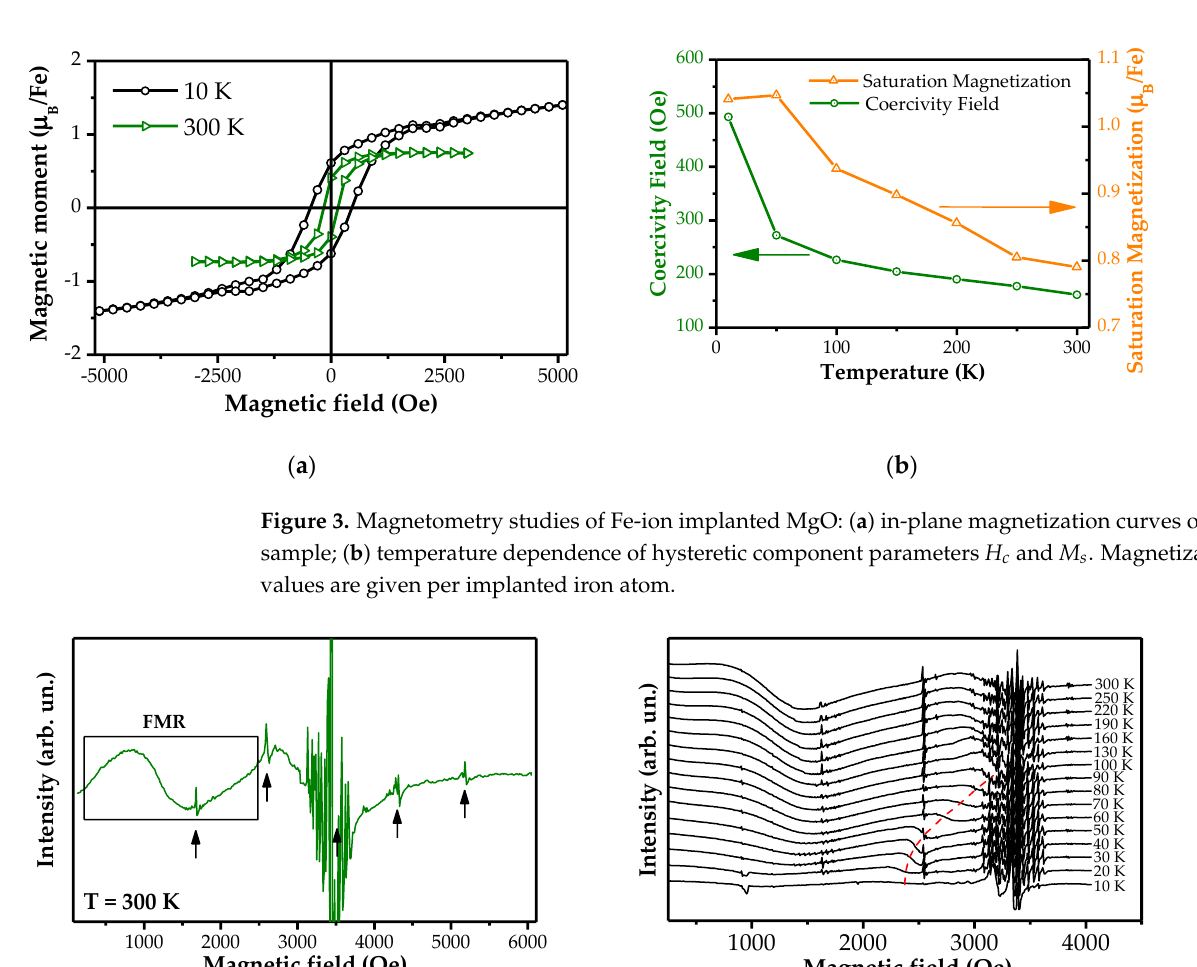
Figure 3. Magnetometry studies of Fe-ion implanted MgO: ( a ) in-plane magnetization curves of the sample; ( b ) temperature dependence of hysteretic component parameters H c and M s . Magnetization values are given per implanted iron atom.